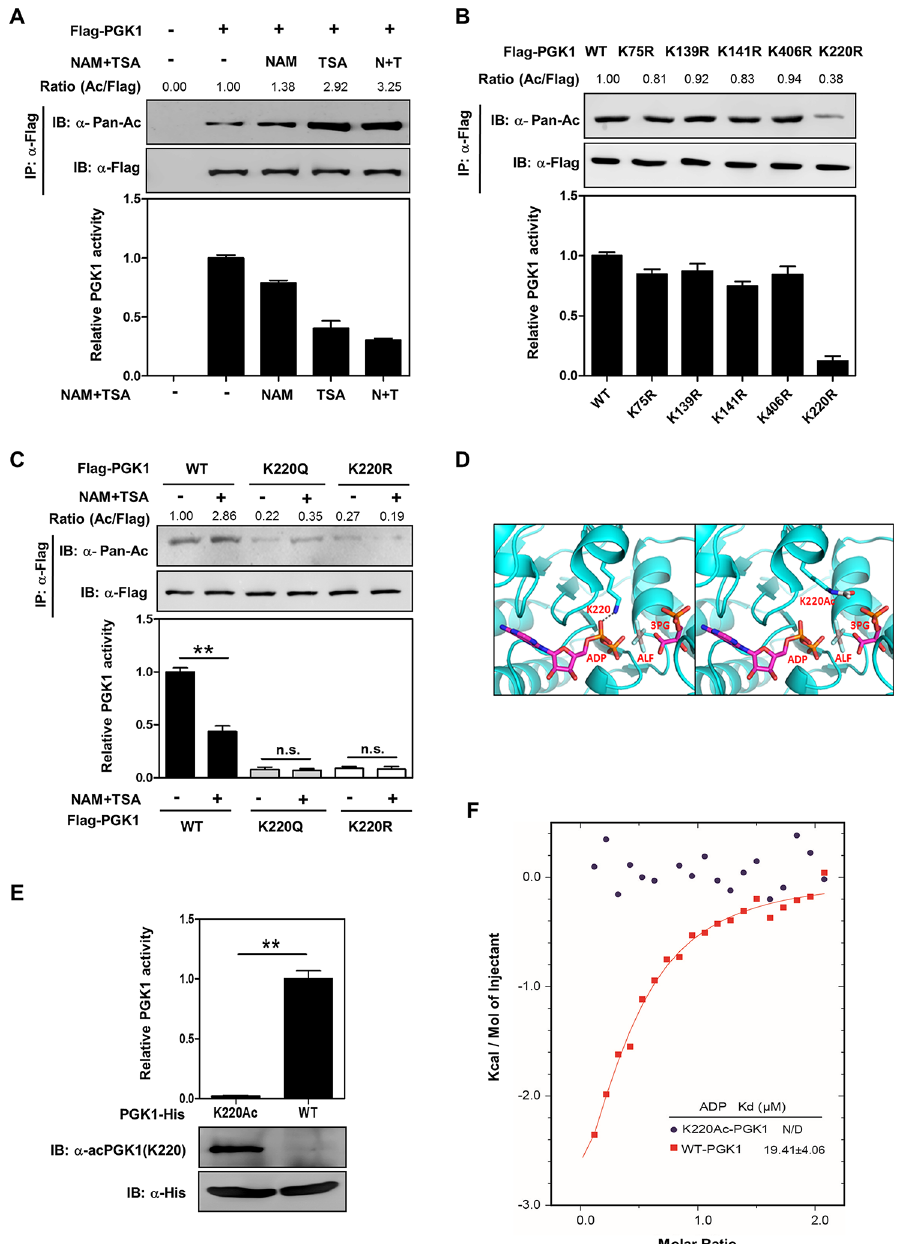
Fig 1. Acetylation of PGK1 K220 blocks substrate ADP binding and inhibits PGK1 activity. ( A ) Acetylation inhibits PGK1 enzyme activity. Flag-PGK1 was overexpressed in HEK293T cells followed by treatment with nicotinamide (NAM, 10 mM for 4 hr), trichostatin (TSA, 5 μ M for 12 hr), or NAM and TSA (N+T). Acetylation levels and enzyme activity of Flag-bead-purified PGK1 were determined by western blot analysis and enzyme assay, respectively. Acetylation levels were blotted with a pan-anti-acetyllysine antibody ( α -Ac). The catalytic activity of affinity purified PGK1 was determined and normalized to protein levels. PGK1 activity under no treatment condition was set as 1. PGK1 acetylation levels were normalized against Flag IB as indicated on the top of each lane. IB and IP denote immunoblotting and immunoprecipitation, respectively. ( B ) Mapping the major regulatory acetylation sites in PGK1. Wild-type (WT) PGK1 and the indicated mutants were each expressed in HEK293T cells. Proteins were purified by IP, and PGK1 activity was determined. Relative PGK1 acetylation levels were normalized against Flag. ( C ) K220 is a major regulatory acetylation site in PGK1. Flag-tagged wild-type and K220 mutant PGK1 were each expressed in HEK293T cells, following treatments with or without NAM (10 mM, 4 hr) and TSA (5 μ M, 12 hr). Acetylation levels and